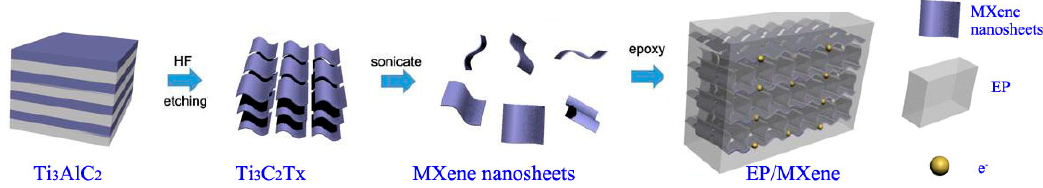
Figure 1. The schematic illustration for the synthetic procedure of the EP/Ti 3 C 2 T x MXene nanosheets